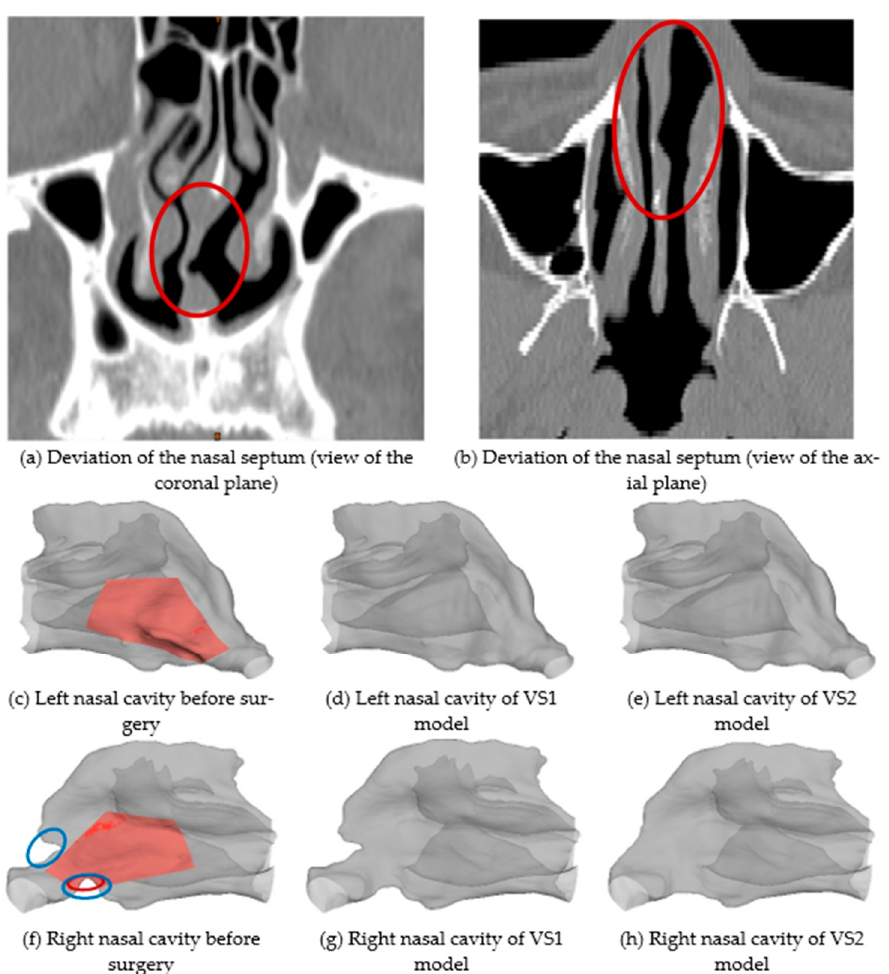
Figure 1. Details of the nasal cavity geometries employed in this study: ( a ) deviation of the nasal septum (view of the coronal plan), ( b ) deviation of the nasal septum (view of the axial plan), ( c ) pre- surgical geometry of the left nasal cavity, ( d ) post-surgical geometry of the left nasal cavity after VS1, ( e ) post-surgical geometry of the left nasal cavity after VS2, ( f ) pre-surgical geometry of the right nasal cavity, ( g ) post-surgical geometry of the right nasal cavity after VS1, and ( h ) post-surgical geometry of the right nasal cavity after VS2.